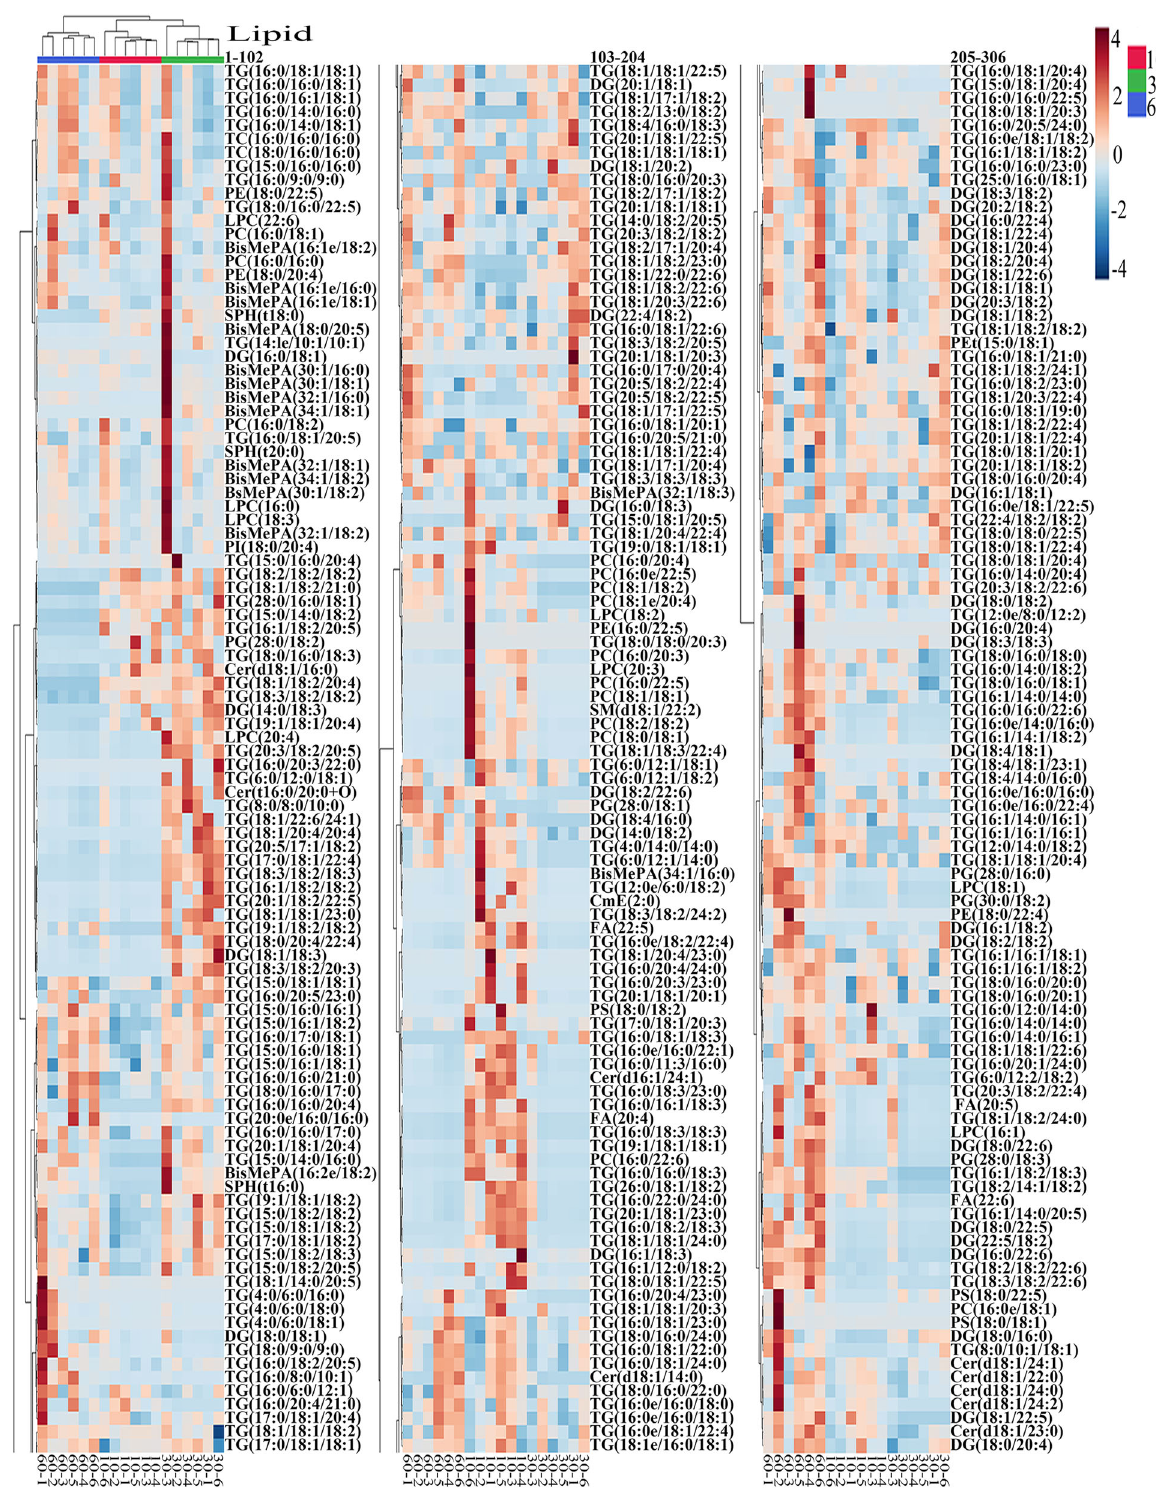
Fig. 4 Heap map of individual lipids in tilapia juice at different steaming times by Metaboanalyst 5.0 online software according to the normalized MS data. Each colored cell in the heat map corresponds to a peak area value of the individual lipid on the right side. In the colored cells, red color is high and blue color is (Table 1 and Supplementary Table 2). They might be destroyed due to heat-induced hydrolysis. (2) Full migration from muscle to juice such as DG and PG. DG and PG are amphipathic lipids and may form liposomes in water 33,34 . Therefore, these lipid classes might